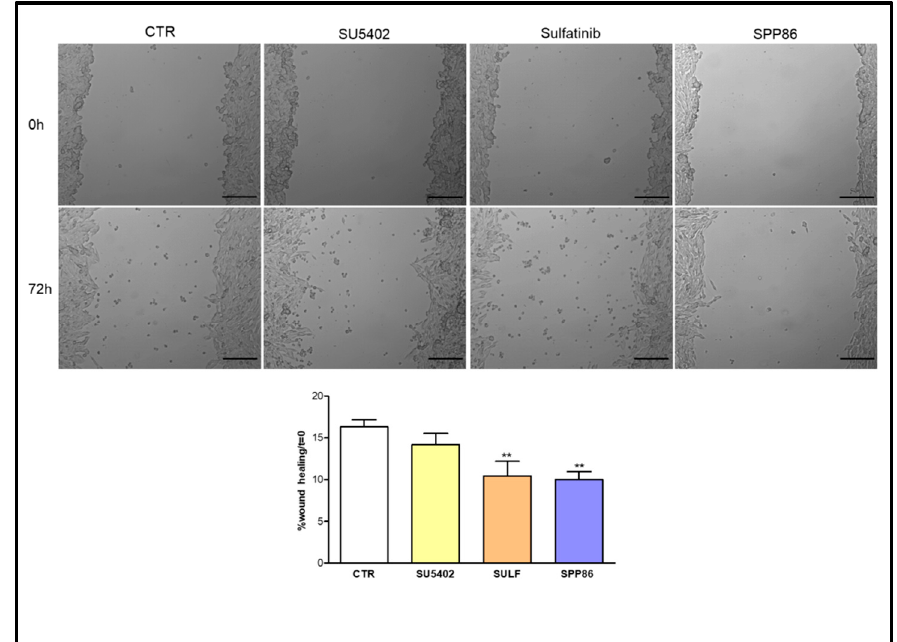
Figure 6. Effect of SU5402, SULF and SPP86 on MZ-CRC-1 cell migration compared to vehicle treated CTR. The area of wound was recorded at 0 and 3 days, and the percentage of wound healing with respect to T0 was calculated using the equation reported in the Material and Methods section. Data were reported as mean ± standard error of the mean of at least 3 independent experiments. Scale bar 200 µm. **: p < 0.01, CTR: control, SULF: sulfatinib.